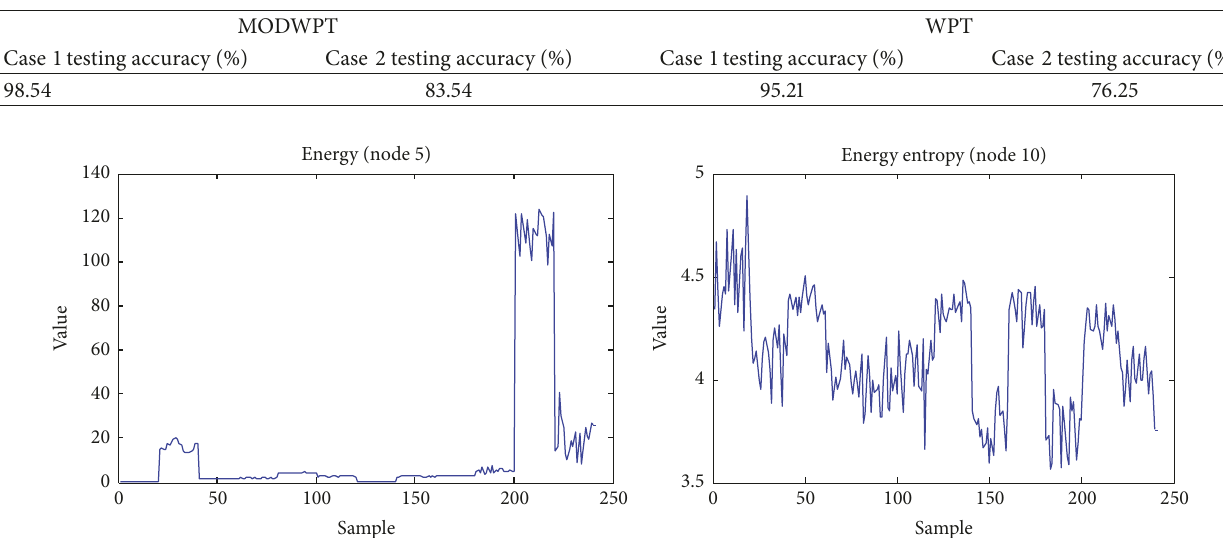
Table 3: Bearing fault diagnosis results obtained by OFS-SVM.